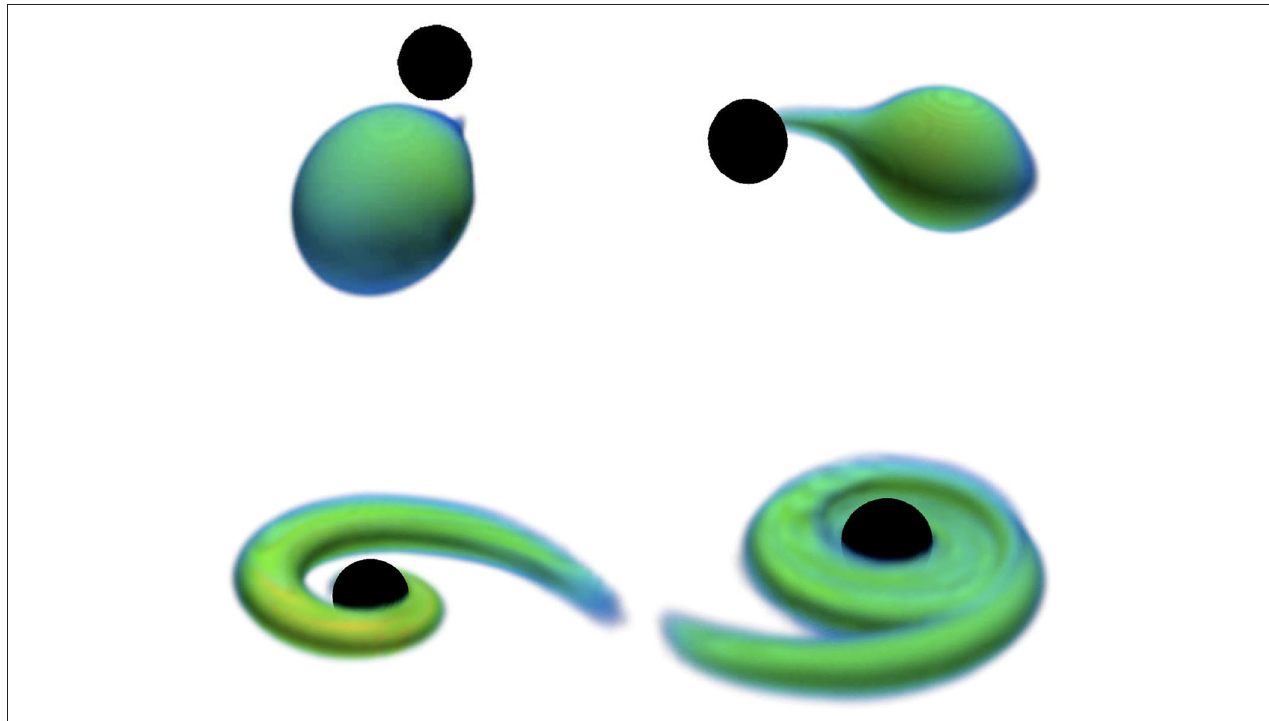
FIGURE 1 | Time evolution of a disrupting BHNS binary, including: onset of mass accretion (top left), unstable mass transfer (top right), evolution into a long tidal tail (bottom left), and circularization into an accretion disk (bottom